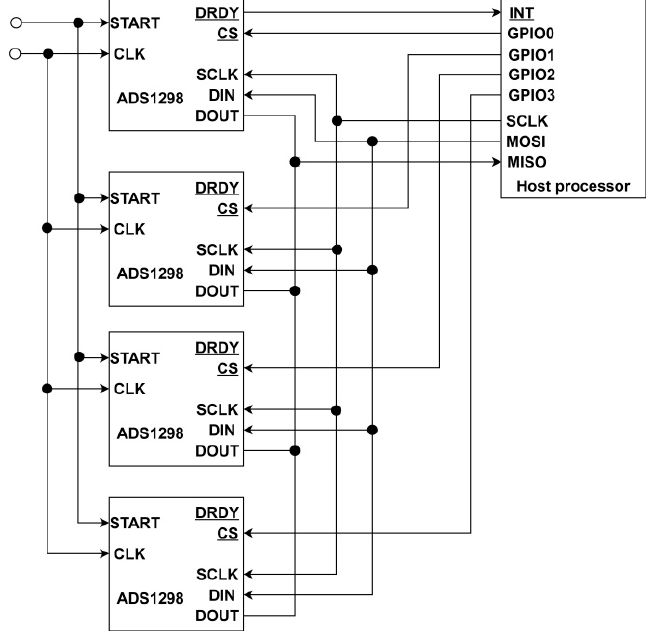
Figure 3. Cascaded view of multiple connected ADS1298 devices.